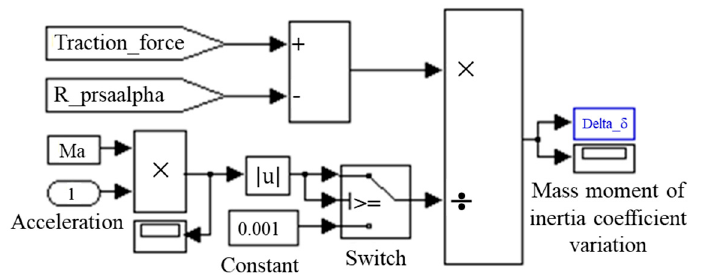
Figure 10. Modeling of traction force and forward resistance forces.